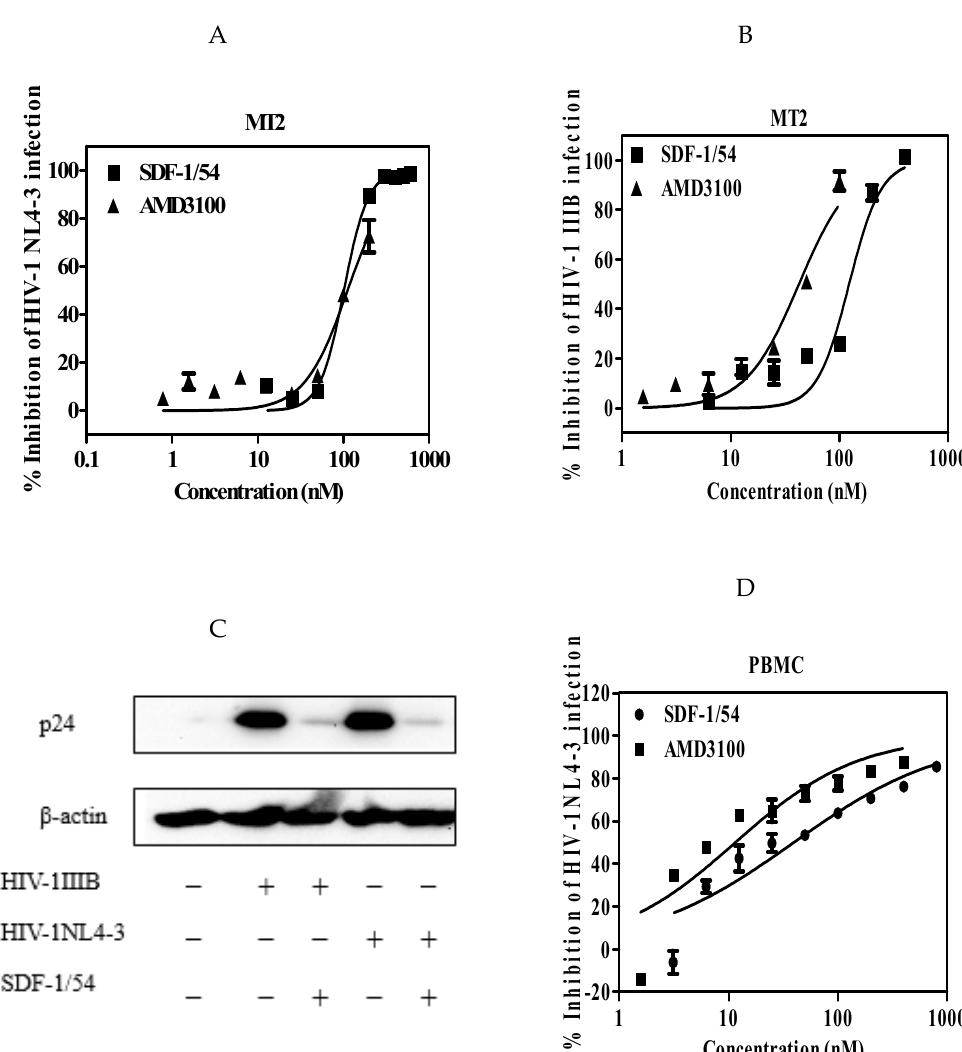
Figure 2. Antiviral potency of SDF-1 / 54 in multiple-cycle viral infection assays. SDF-1 / 54-mediated inhibition of infection by infectious clone HIV-1 NL4-3 ( A ) and laboratory-adapted HIV-1 IIIB ( B ) of MT-2 cells. MT-2 cells were pre-incubated with graded concentrations of inhibitor for 15 min at 37 ◦ C. Next, mixtures were mixed with viruses. The culture medium was refreshed after overnight incubation. At 96 h post-infection, supernatant was collected and lyzed for p24 determination by ELISA and Western blotting ( C ). ( D ) SDF-1 / 54-mediated inhibition of infection by infectious clone HIV-1 NL4-3 in PBMC. Average values ( ± SD) from three independent experiments are shown. Table 2. The inhibitory activities of SDF-1 / 54 on infection by two HIV-1 strains in MT-2 cells and PBMC.